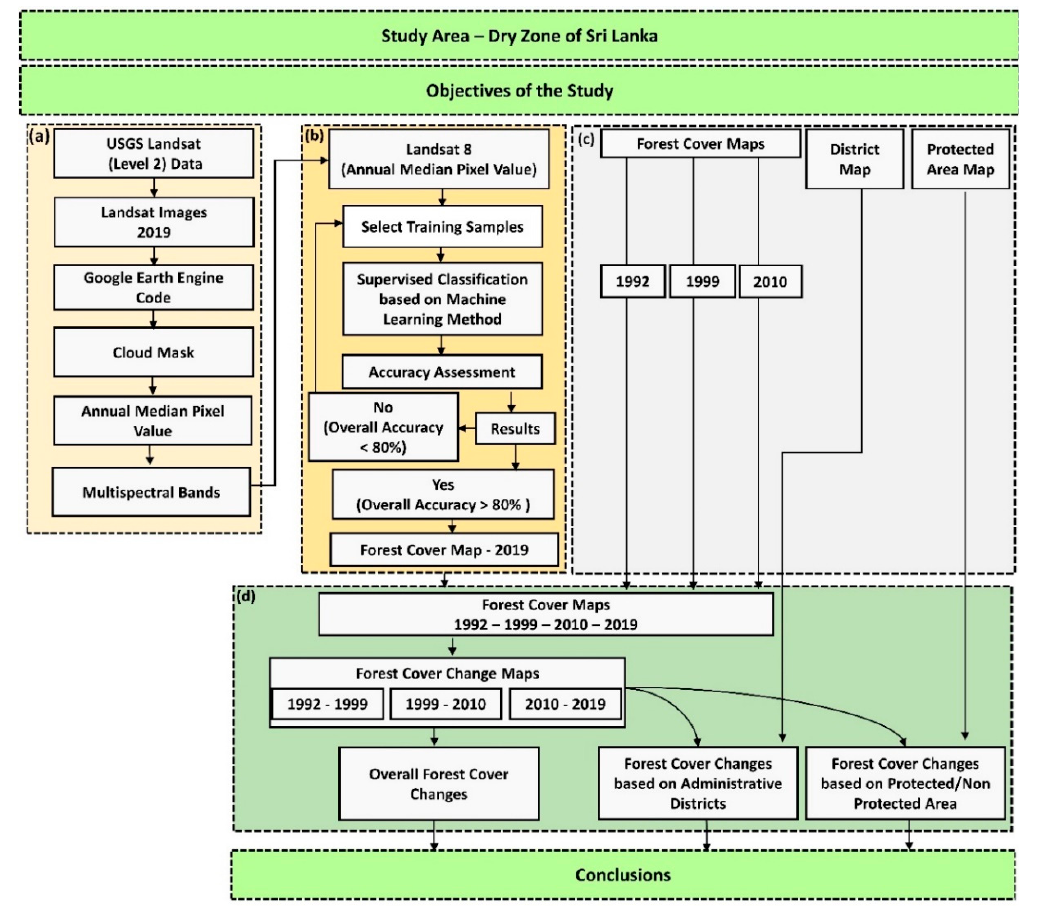
Figure 2. Workflow of the methods used in this study: ( a ) Landsat data preparation using Google Earth Engine; ( b ) forest cover classification; ( c ) secondary data sources; and ( d ) forest cover changes.